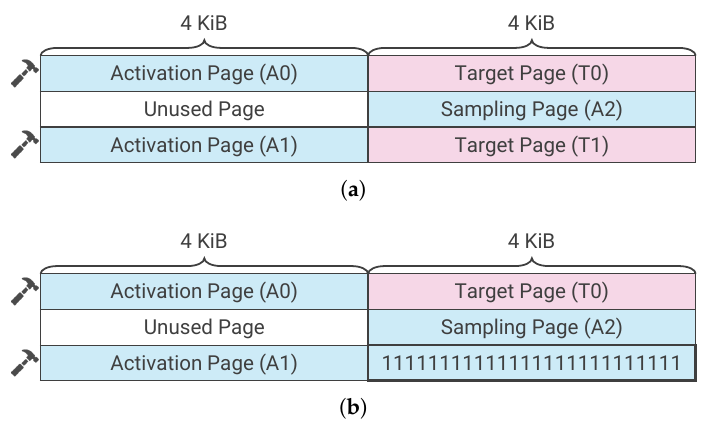
Figure 3. Memory layouts used for RAMBleed. The layouts consist of activation, target, and sampling pages. The attacker inducts secrets into target pages and repeatedly accesses pages A0 and A1 to activate the pages. The rowhammer effect causes the bits in the sampling page to invert, and the attacker can infer the secret by observing it. ( a ) Memory layout used by Kowng et al. for RAMBleed. ( b ) Simplified memory layout used in this study for